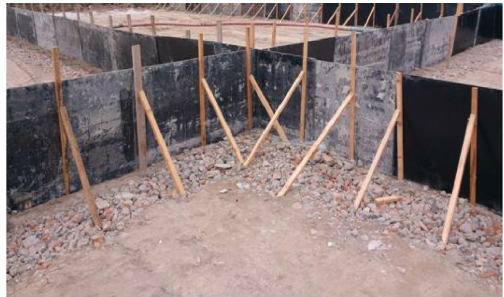
Figure 6: Partition panel.